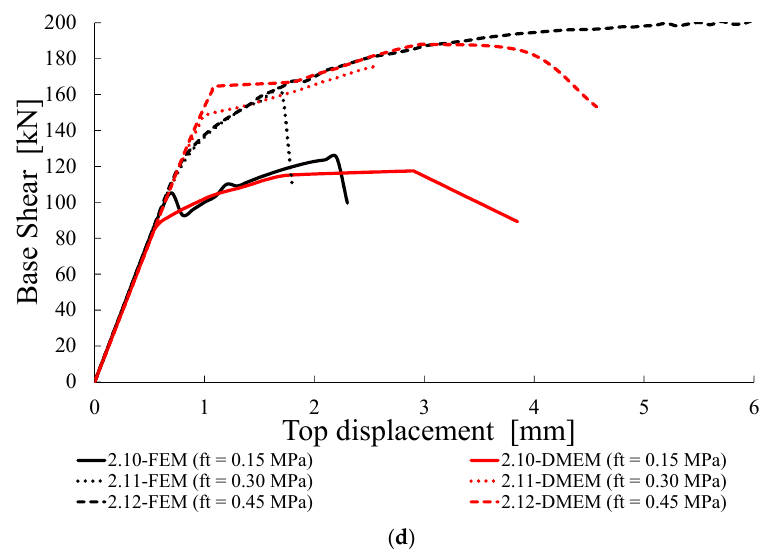
Figure 12. Capacity curves for Group B: ( a ) σ 0 = 0.3 MPa and f c = 3.0 MPa, ( b ) σ 0 = 0.3 MPa and f c = 4.5 MPa, ( c ) σ 0 = 0.6 MPa and f c = 4.5 MPa, ( d ) σ 0 = 0.6 MPa and f c = 6.0 MPa.